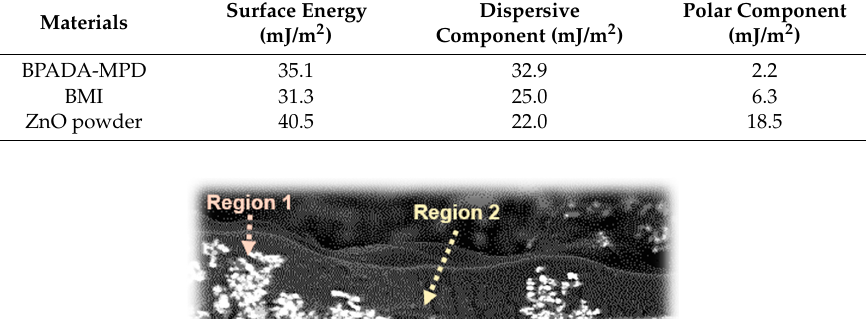
Table 2. Surface energies of BPADA-MPD, BMI resin, and ZnO powder [19–21]. Materials